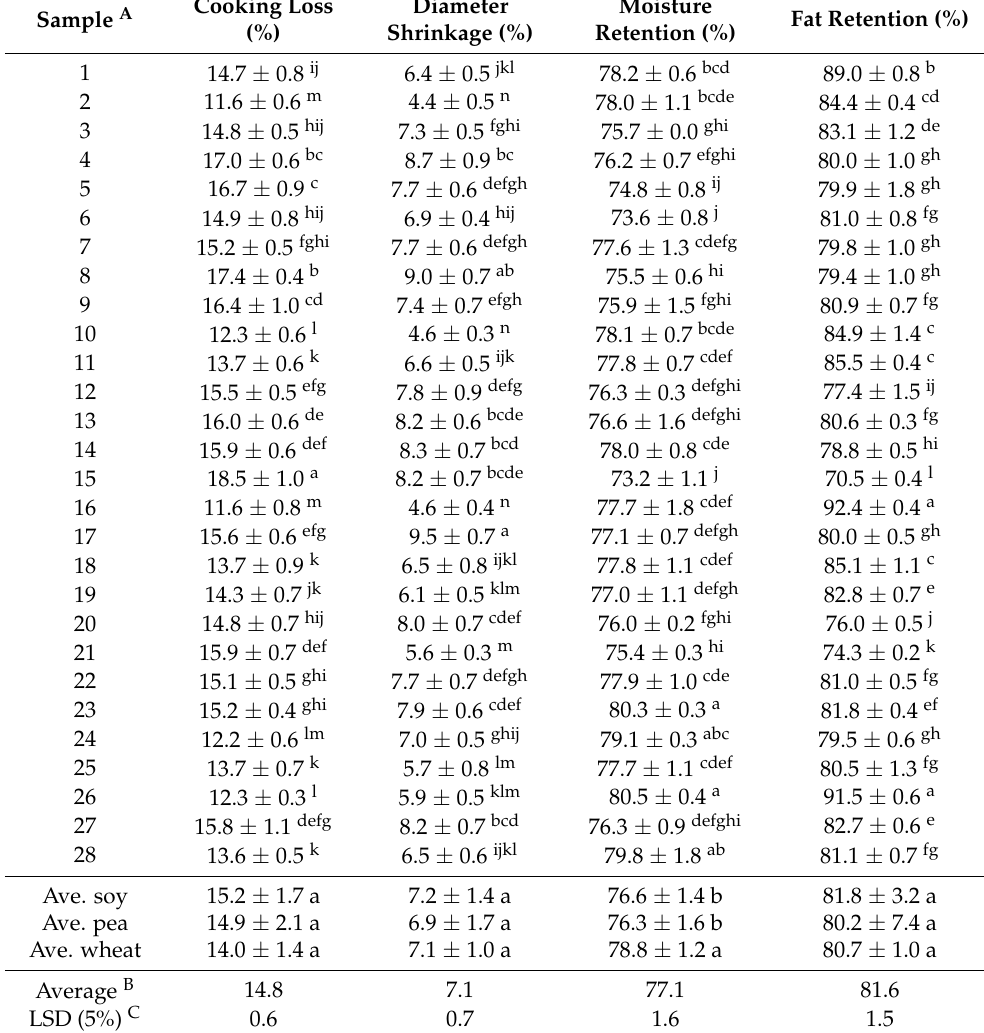
Table 5. Cooking properties of TVP-based